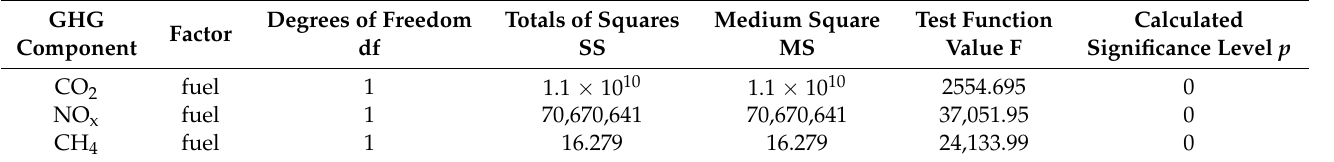
Table 7. ANOVA results for the emission levels of GHG components (g · kWh − 1 ) by fuel (rapeseed straw pellets, wood